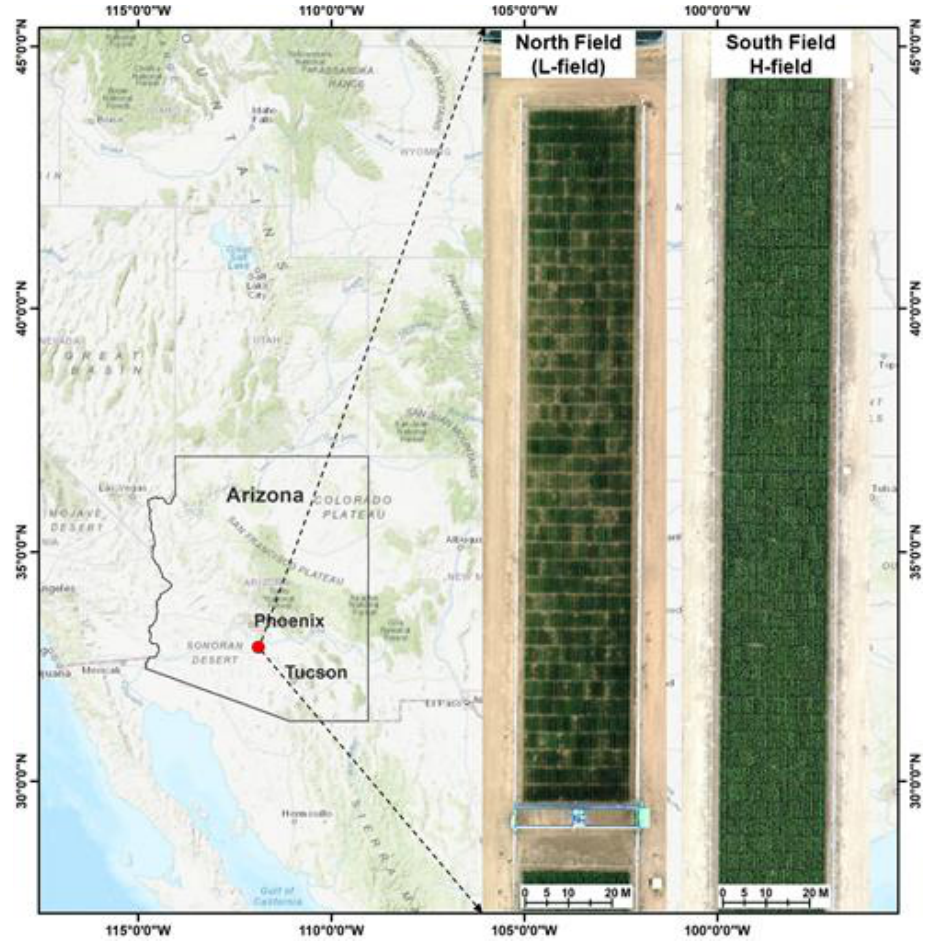
Figure 1. Study site location and UAV-based RGB imagery of two fields (north and south field). The north field was denoted as L-field (Low and sparse canopy), and the south field was denoted as H-field (high and dense